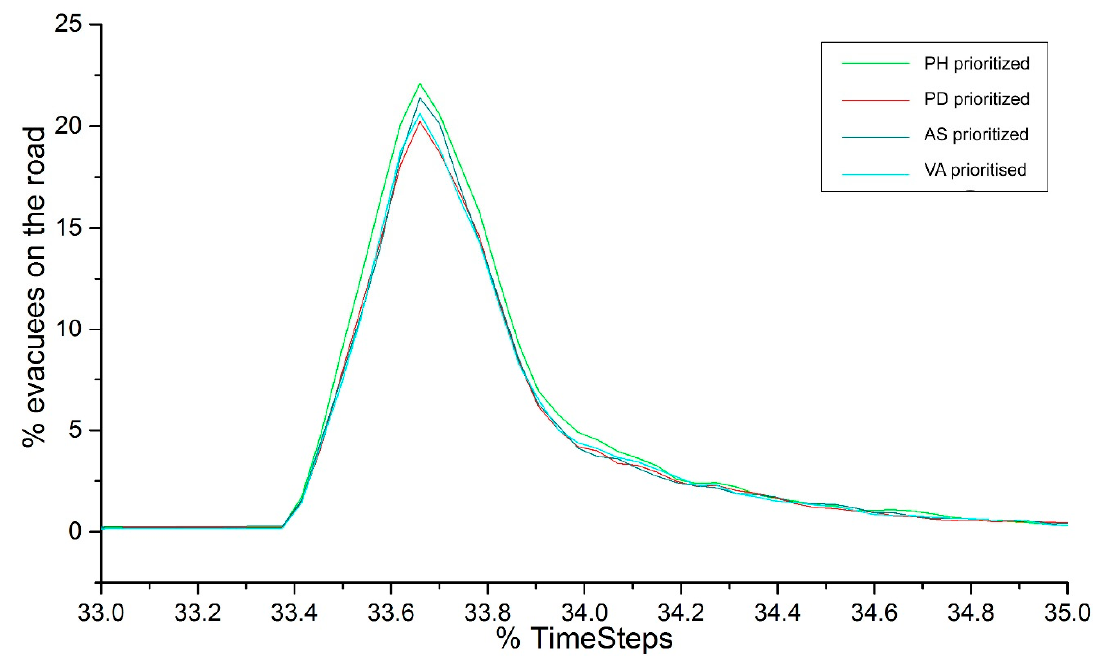
Figure 12. Performance comparison among the four staged scenarios.